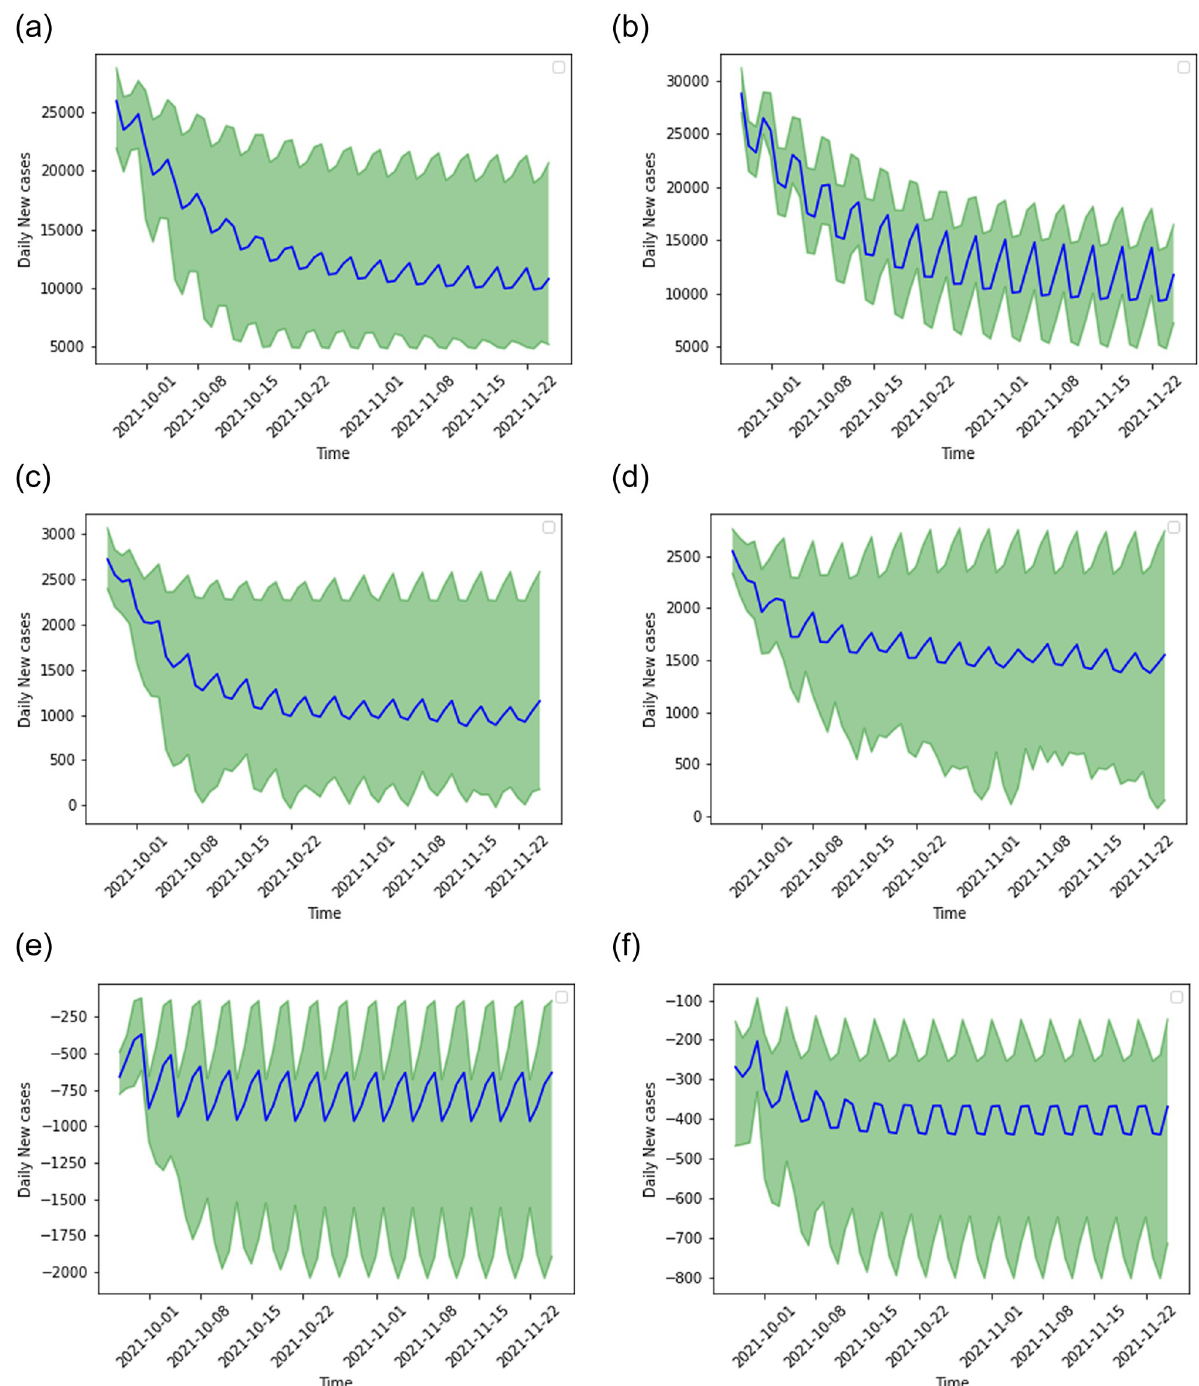
Fig 11. Recursive univariate LSTM and BD-LSTM models predictions for next 60 days (October and November 2021). The uncertainty (95% confidence interval shaded in green) and mean prediction is shown in solid black line.